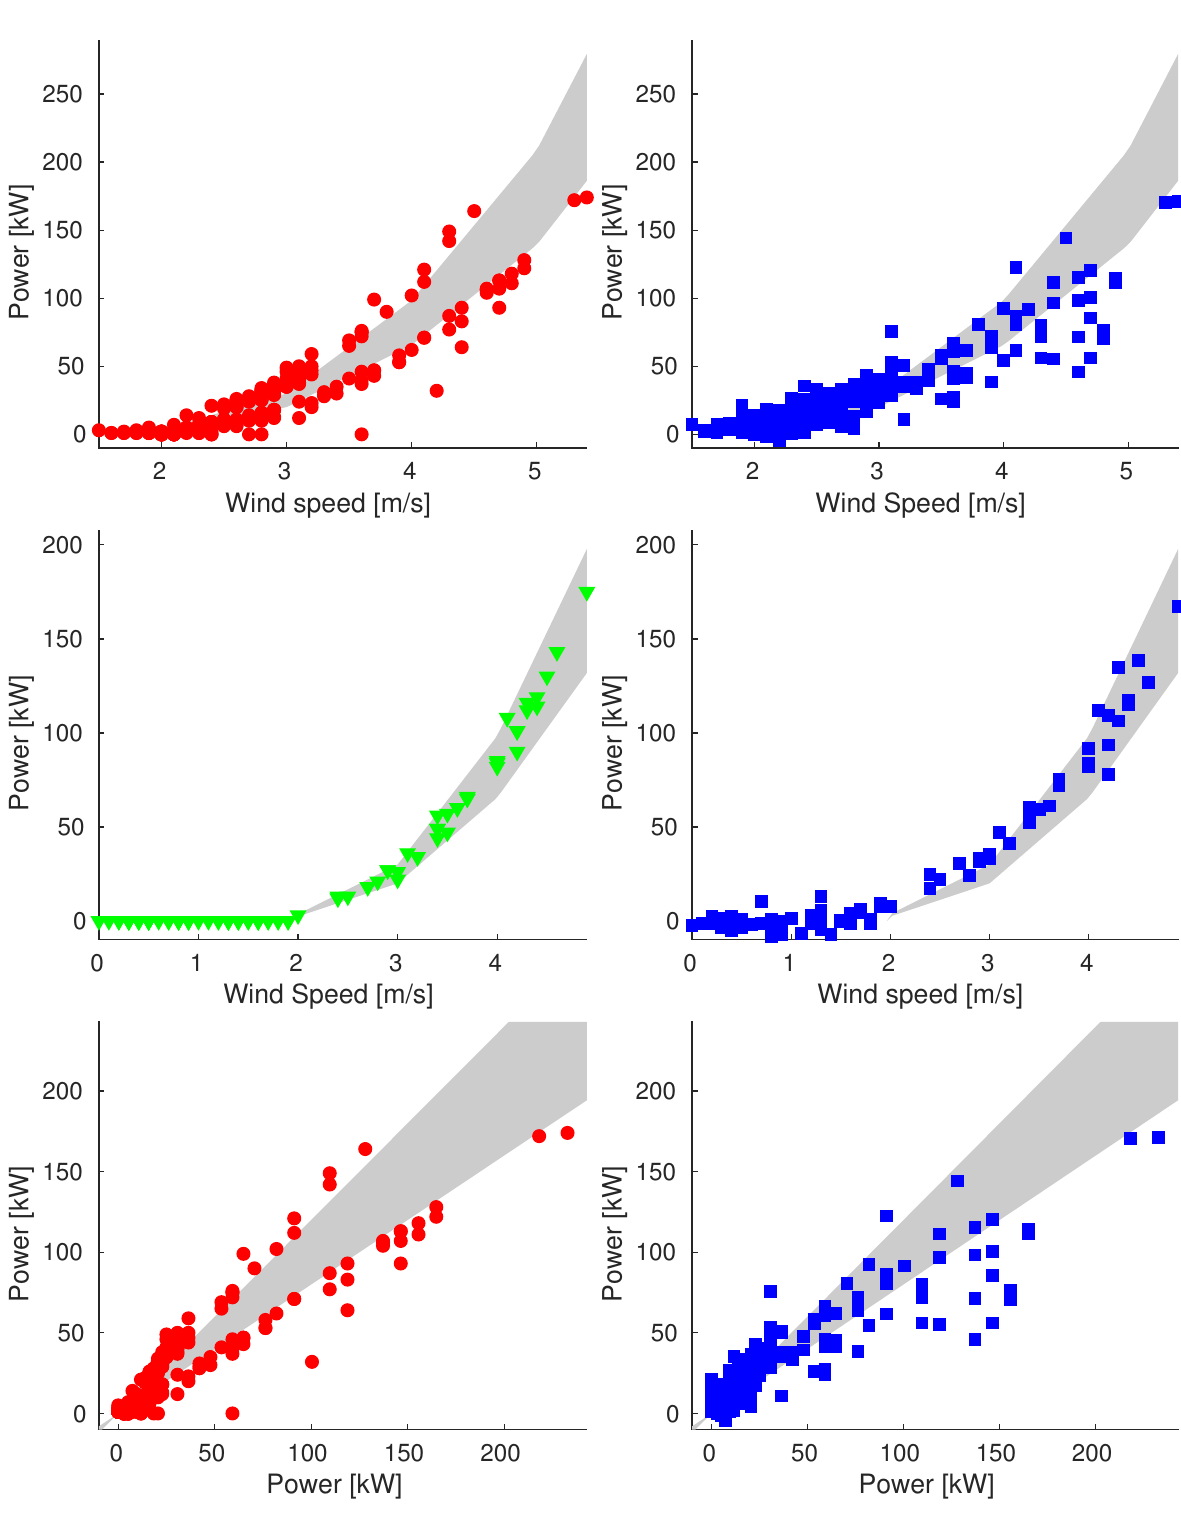
Figure A2. Plot of reconstructions for data points of 26 July ( Sample_75 ). We compare original data (on the left ) and reconstructed values (on the right ). We show plots of power vs. wind speed of rejected and validation data ( up and middle respectively) and plot of power vs. ideal power of rejected data ( bottom